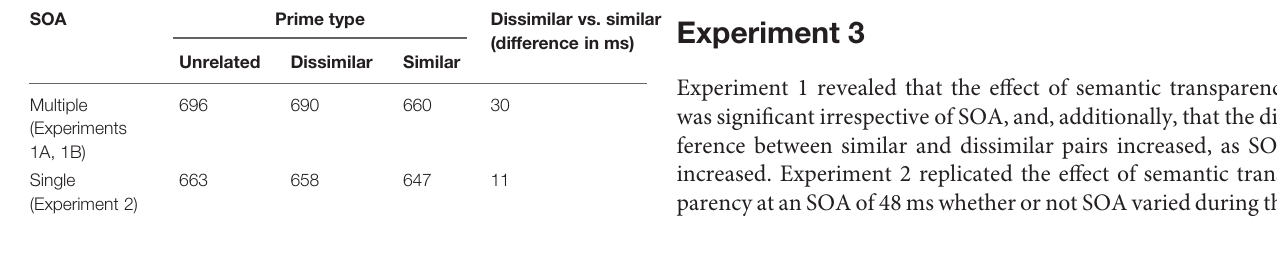
TABLE 4 | Raw values of mean decision latency for targets after (form similar) semantically similar, dissimilar, and unrelated primes at 48 ms SOA, contrasting data from Experiment 1 with multiple SOAs, and Experiment 2 with 48 ms SOA only. SOA